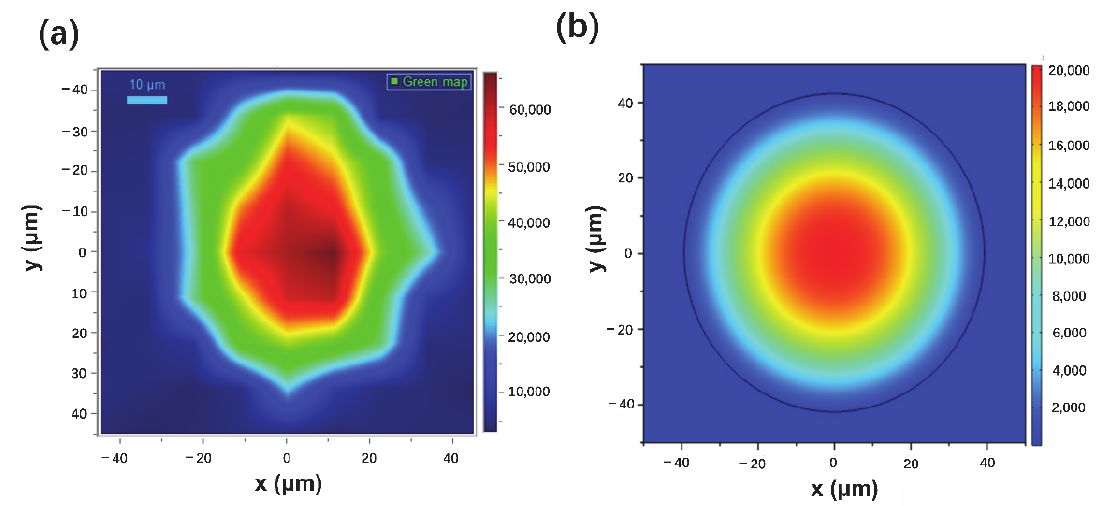
Figure 6. Raman intensities distribution mapping of SERS fiber probe terminal end ( a ) and Raman intensities distribution mapping of blank fiber terminal end ( b ).